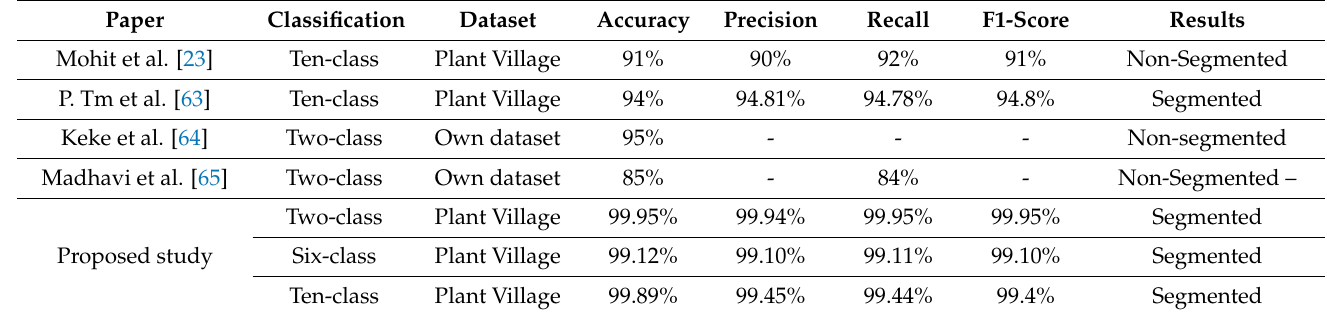
Table 8. Results in the paper compared with other state-of-the-art